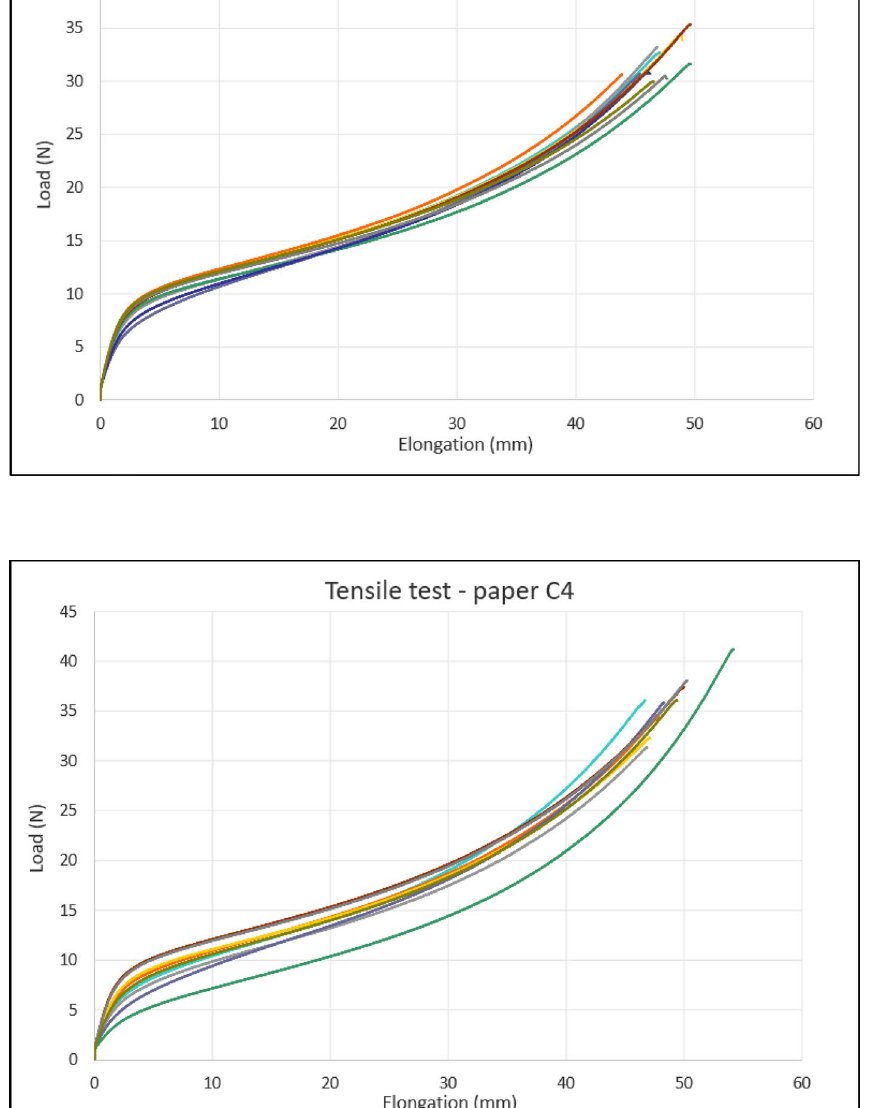
Fig. 28 Force elongation curves of individual specimen of paper C3